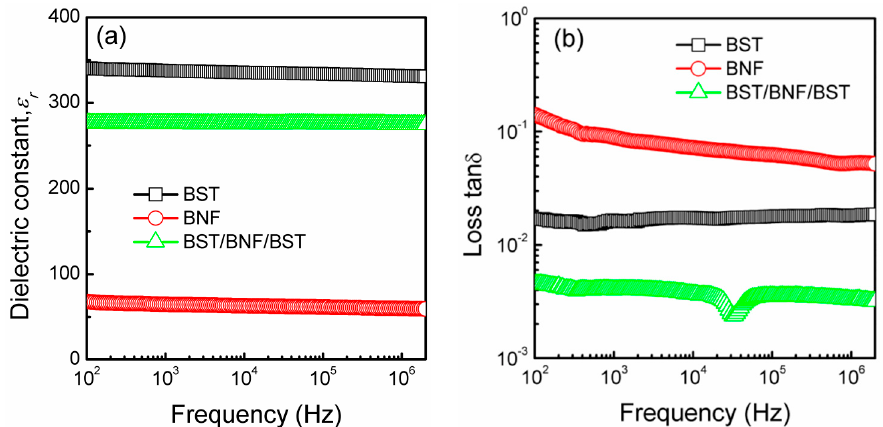
Figure 3. The dielectric constant ( a ) and loss tan δ ( b ) versus frequency for BST, BNF and BST/BNF/BST films on Pt(111)/Ti/SiO 2 /Si(100) substrate measured at room temperatures.